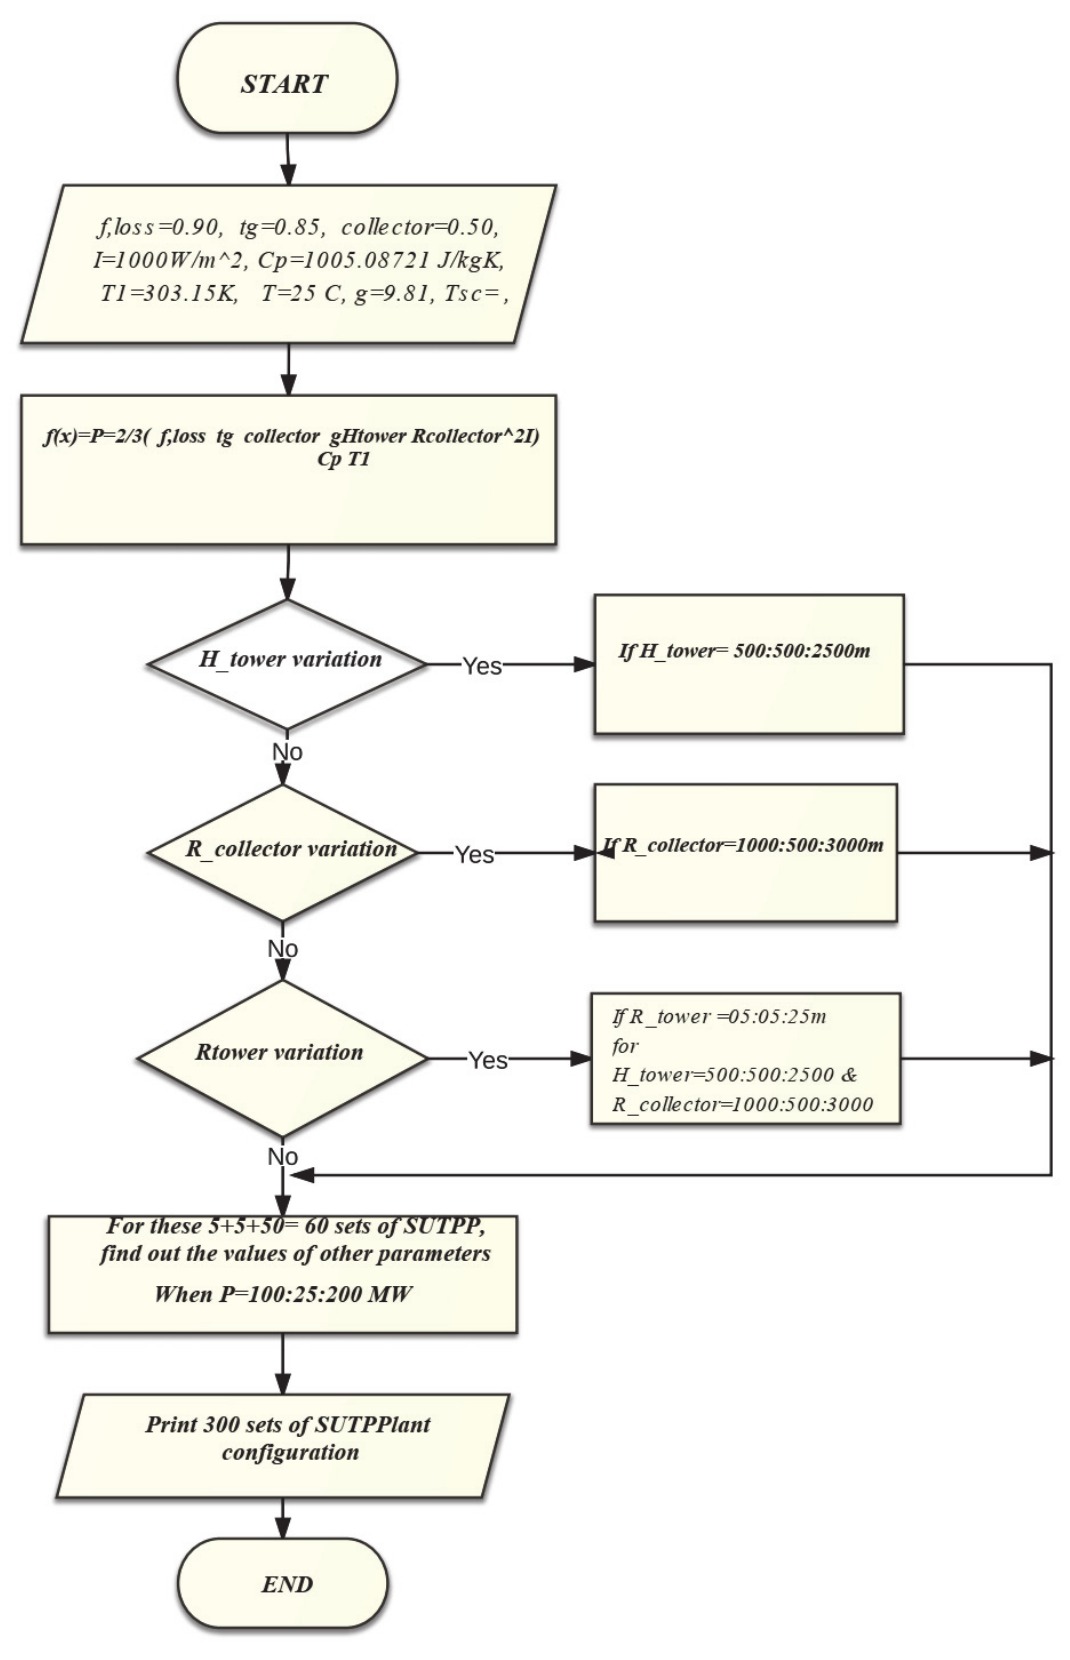
Figure 8. Flow chart of program for generating 100 sets of SUTPP configuration.